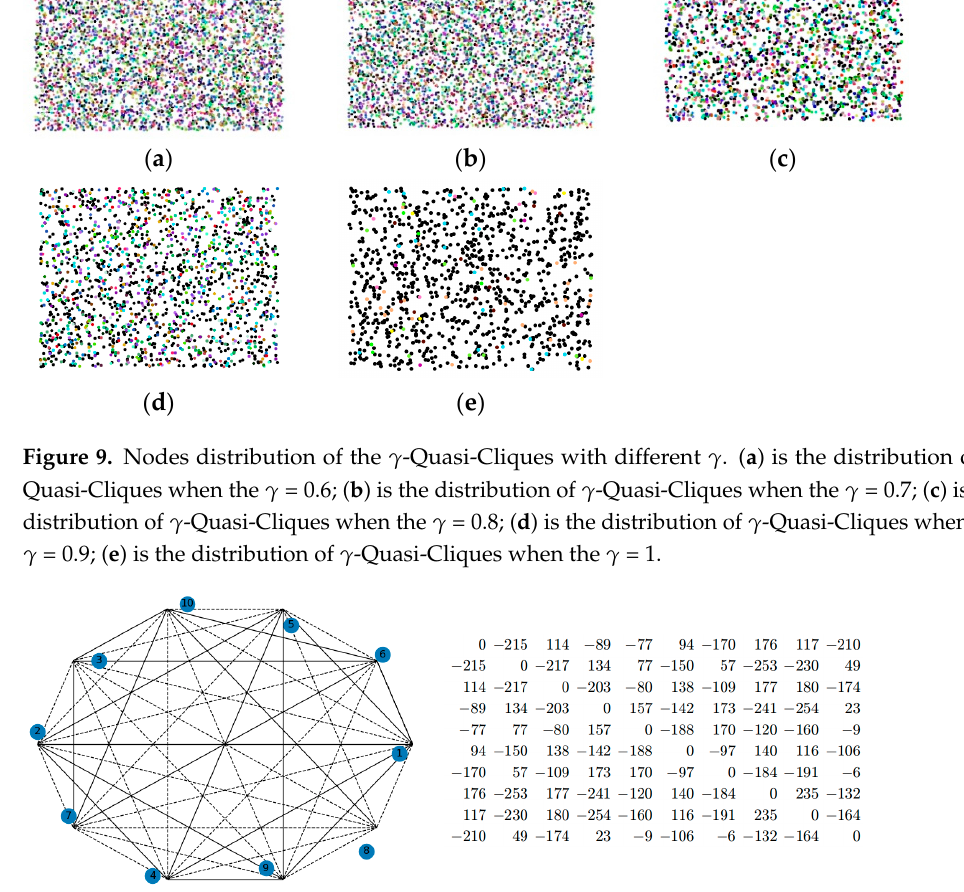
Figure 10. Ten parties of the Slovene Parliament.